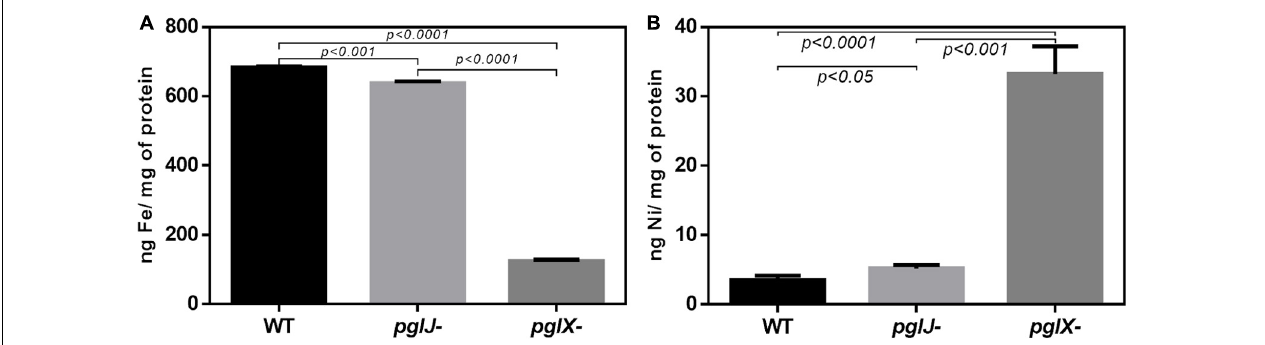
FIGURE 8 | Cellular iron and nickel content of Cff WT, pglX-, and pglJ - strains. Atomic absorption spectroscopy (AAS) was employed for the detection of (A) iron (Fe) and (B) nickel (Ni) in lysed cells of the indicated strain. Data are presented as the mean of at least three replicates, error bars depict the standard deviations. Statistically significant differences determined by a two-tailed t -test are